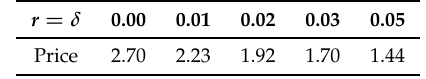
Table 4. HWB price estimates for varying r = δ